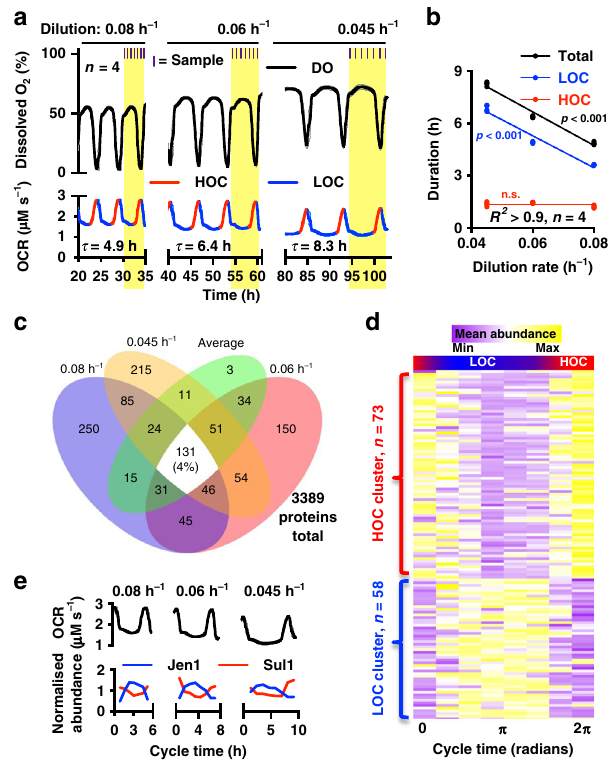
Fig. 1 Rhythms in oxygen consumption and protein abundance at three dilution rates. a The period ( τ ) of oscillation, which is made up of stages of higher and lower O 2 consumption (HOC, LOC), varies with dilution rate (mean ± SEM are used throughout, n = 4 biologically independent samples). Samples were harvested at the times shown. b the duration of LOC, not HOC, varies with dilution rate (extra sum-of-squares F test: straight line vs. horizontal line fi t, p HOC = 0.07, n = 4 biologically independent samples). c Of 3389 proteins detected by quantitative mass spectrometry, only 4% were consistently rhythmic (varied by >33% across all conditions). d Heatmap showing mean abundance of consistently rhythmic proteins clustered with either LOC or HOC (see also Supplementary Data 1). e Oxygen consumption and mean-normalized protein abundance, for representative examples of HOC (high-af fi nity sulfate permease, Sul1) and LOC (monocarboxylate transporter, Jen1) phase proteins. Source data are provided as a Source Data fi